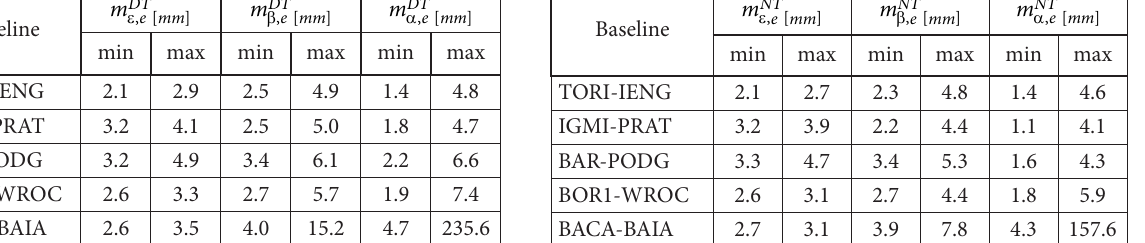
Table 1. Extreme values of epoch-wise standard deviations estimates for the coordinate e and the daytime ( DT ) period Baseline